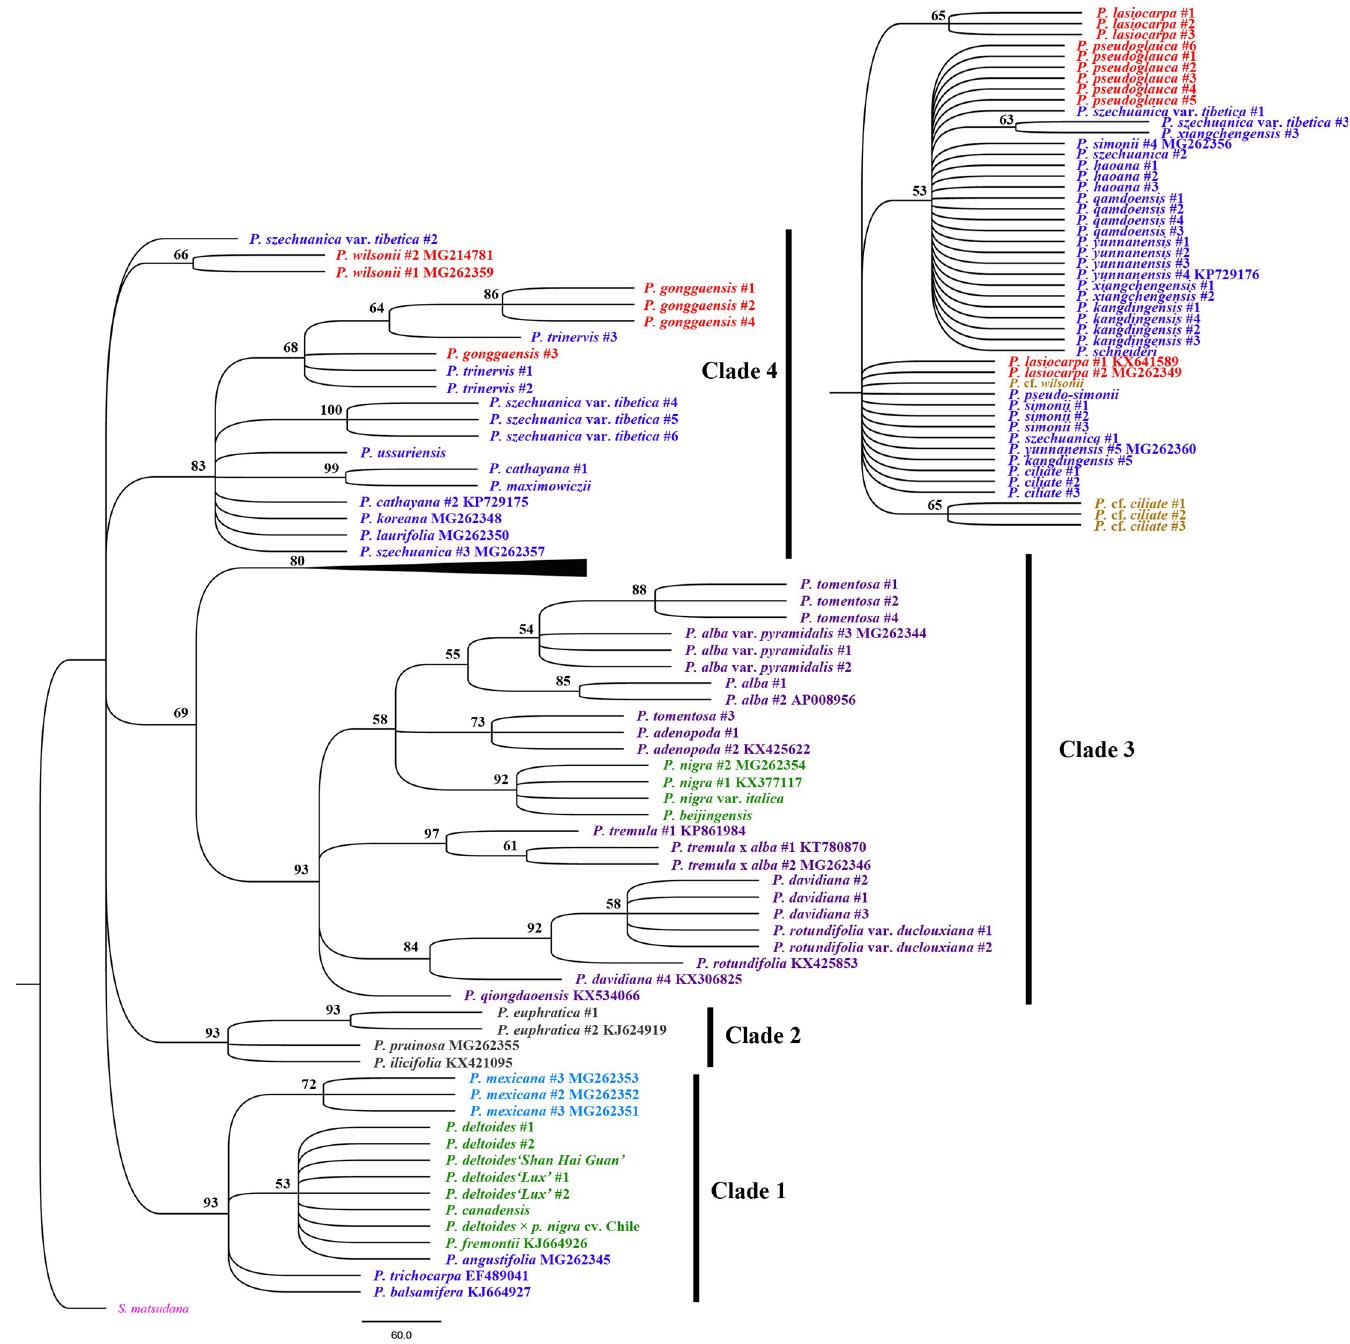
Fig 3. MP phylogenetic tree based on the combined data for all eight chloroplast regions. Bootstrap support values are reported for nodes over 50%. The traditional species taxa, based on morphological characteristics, are shown in different colors. The outgroup is pink, Tacamahaca is blue, Aigeiros is green, Leuce is purple, Leucoides is red, Turanga is brown, Abaso is skyblue, and hybrids are yellow. https://doi.org/10.1371/journal.pone.0206998.g003 mixed (0.98 posterior probabilities), and they were clearly separated from section Turanga (1.00 posterior probabilities). All American Populus species formed subclade 2 (1.00 posterior probabilities), in which P . mexicana was identified with 1.00 posterior probabilities. These two